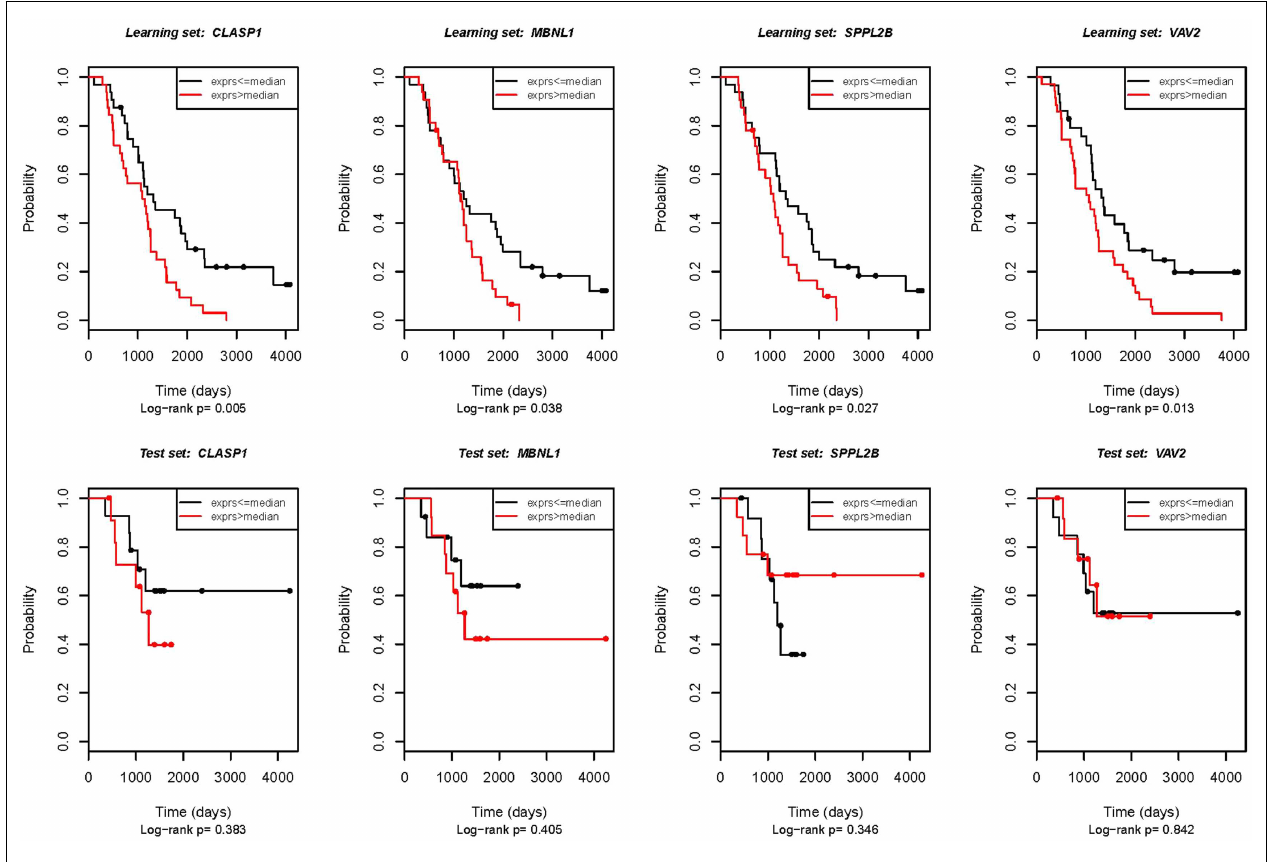
row: external validation in the independent patient group.The Kaplan–Meier analysis plot of observed overall survival for patients with ovarian cancer by log-rank test according to real-time RT-PCR estimated gene